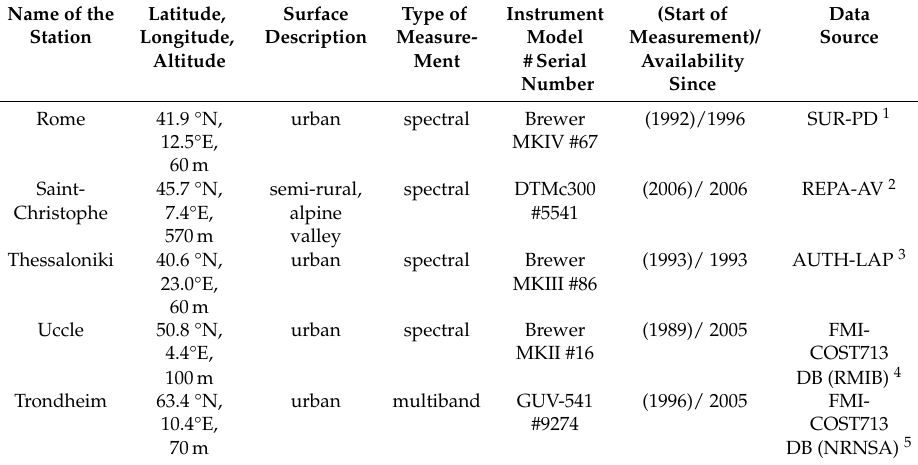
List of the stations providing ground-based UV measurements, used in this study for the validation of the satellite-based UV-Index (UVI) (Instrument model: Spectroradiometer Type Brewer MKII, MKIV; Spectroradiometer: Bentham DTMc300, Multichannel